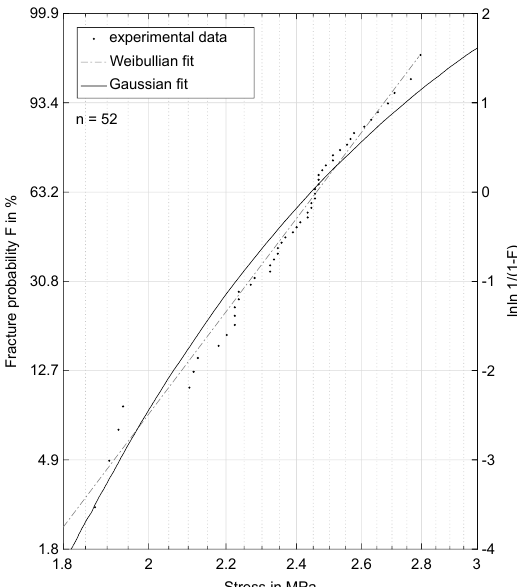
Figure 4. Strength probability distribution with Gaussian and Weibullian fit.